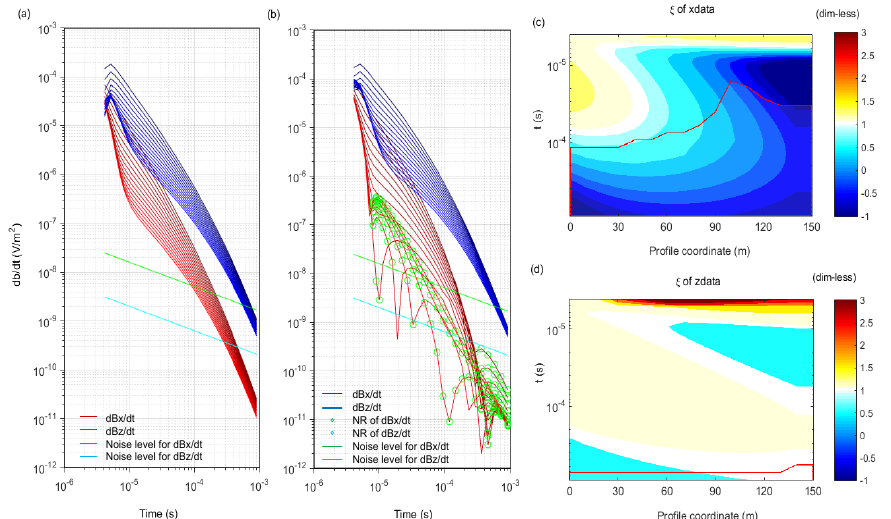
Figure 5. Results of forward modeling for the moderate chargeable medium: ( a ) non-IP responses and ( b ) IP responses; ( c ) ξ for the x -component; and ( d ) ξ for the z -component. The meanings of the curves and area are the same as in Figure 4.